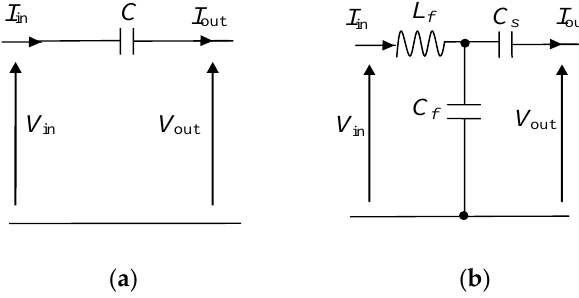
Figure 1. Series ( a ) and inductor-capacitor-capacitor (LCC) ( b ) compensation circuits used for each circuit side [i.e., ground assembly (GA) and vehicle assembly (VA) coils].